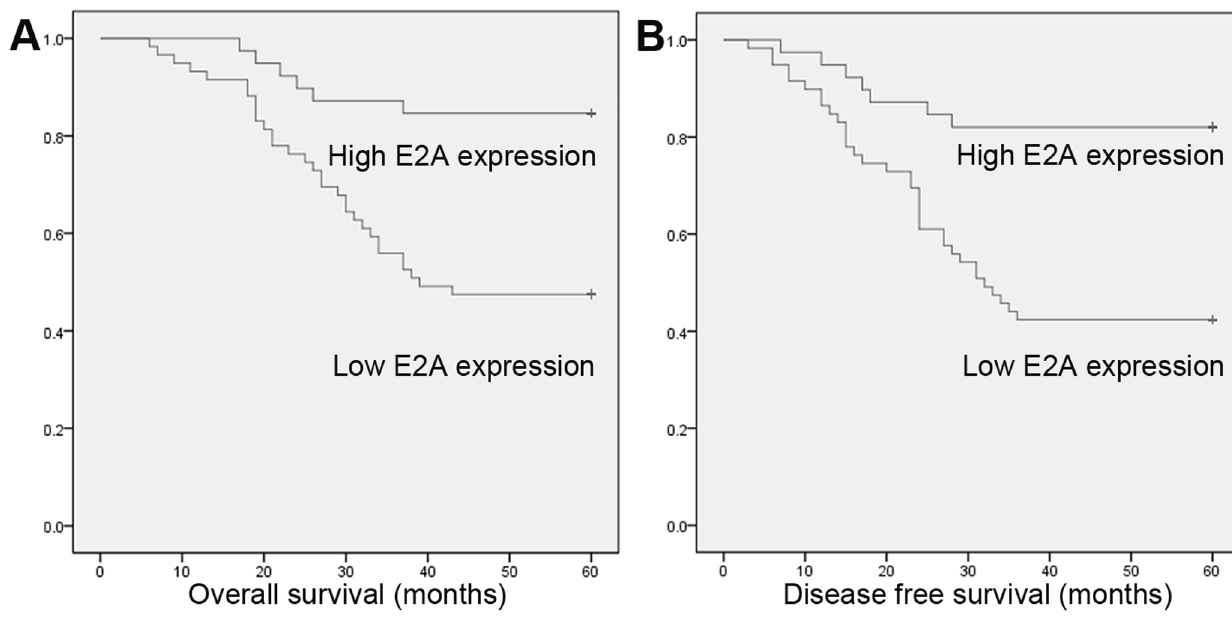
Figure 2. Kaplan-Meier survival curves for OS and DFS stratified by E2A expression. (A) OS for high and low E2A expression patients; (B) DFS for high and low E2A expression patients. Patients with high E2A expression have more favorable OS and DFS ( P =0.000, for OS and DFS both).